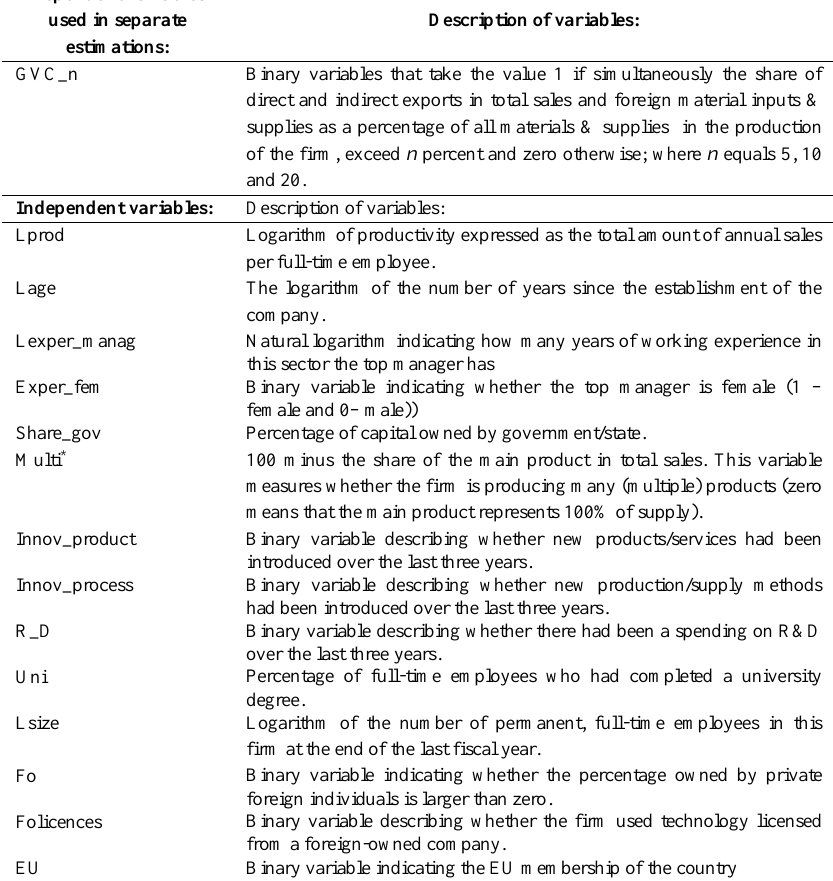
Table 2. Variables used in the empirical analysis Dependent